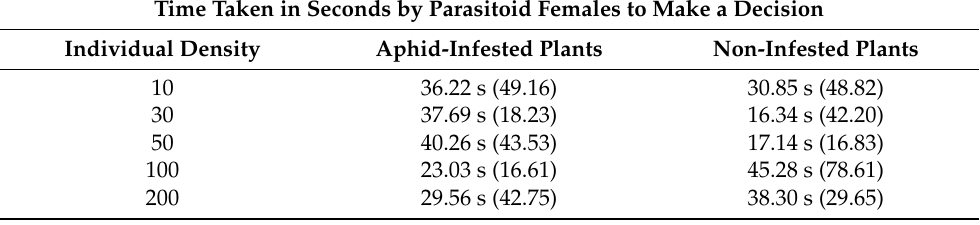
Table 1. The time taken (Median with IQR) in seconds by Aphidius ervi females to make a decision between aphid-infested and non-infested plants. No significant differences were found.